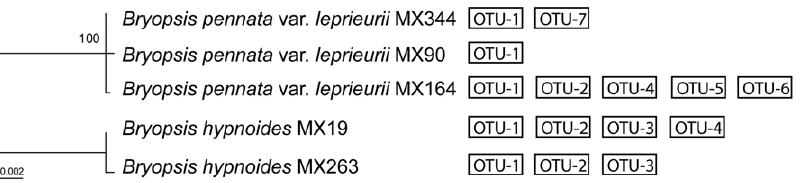
Figure 4. Endophytic diversity results (right) plotted against the Bryopsis host phylogeny (left). The OTU diversity (1–7) displayed on the right summarizes the diversity results from the clone libraries and DGGE analyses. The concatenated chloroplast 16S rRNA gene - rbc L maximum likelihood tree on the left classifies the Bryopsis MX samples in two distinct species clades with 100% bootstrap support. The scale bar indicates 0.002 nucleotide changes per nucleotide